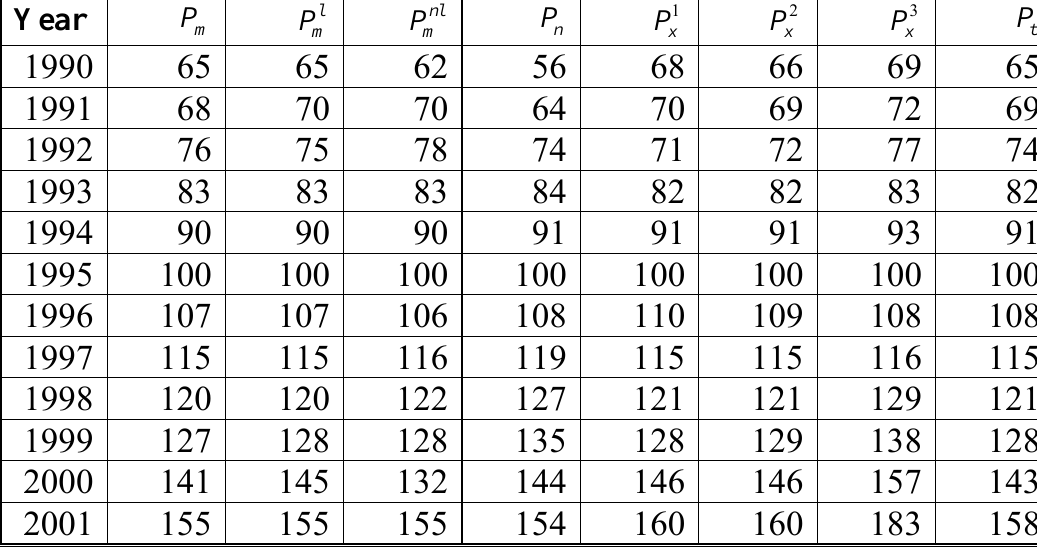
Price series of exportables, importables, tradables and non-